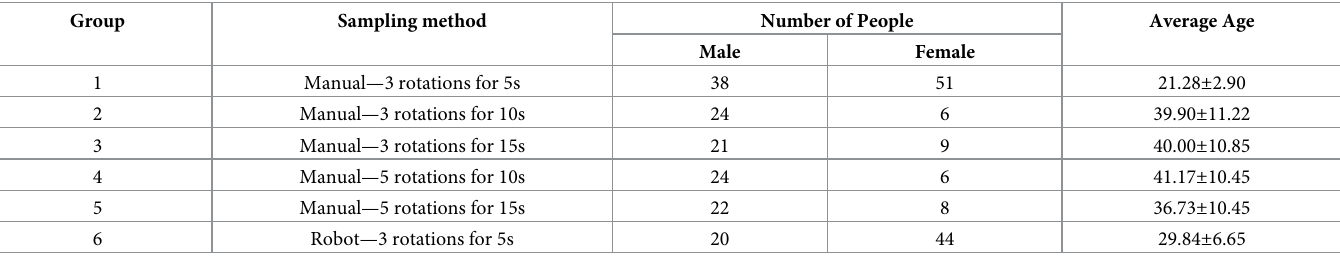
Table 3. Basic information of enrolled